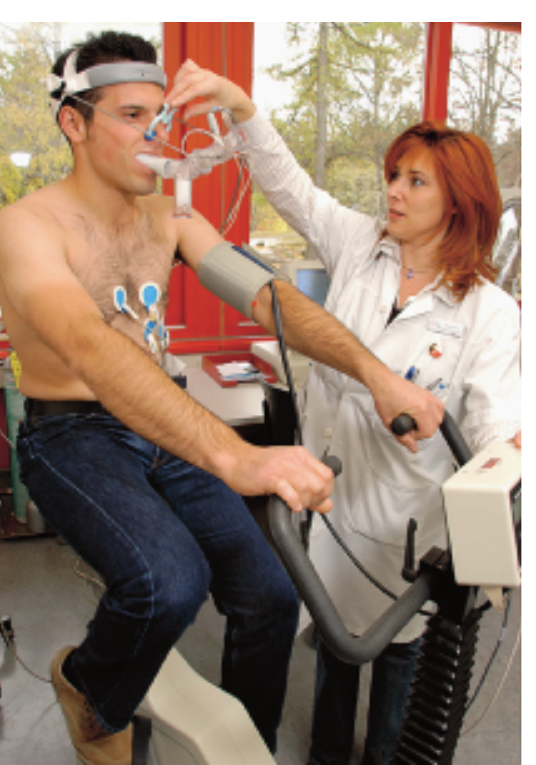
technologies and specialised staff.